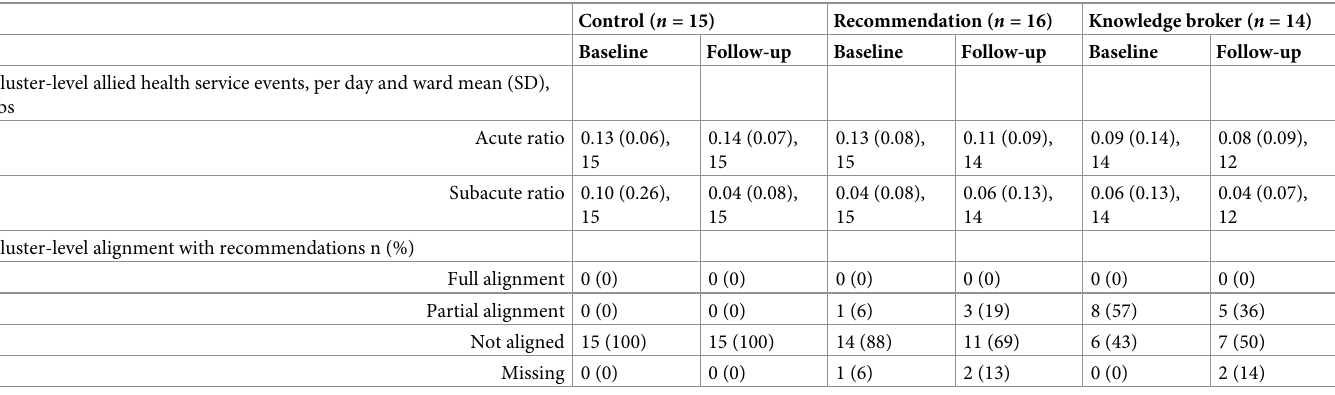
Table 4. Cluster-level summative raw data for primary outcome.